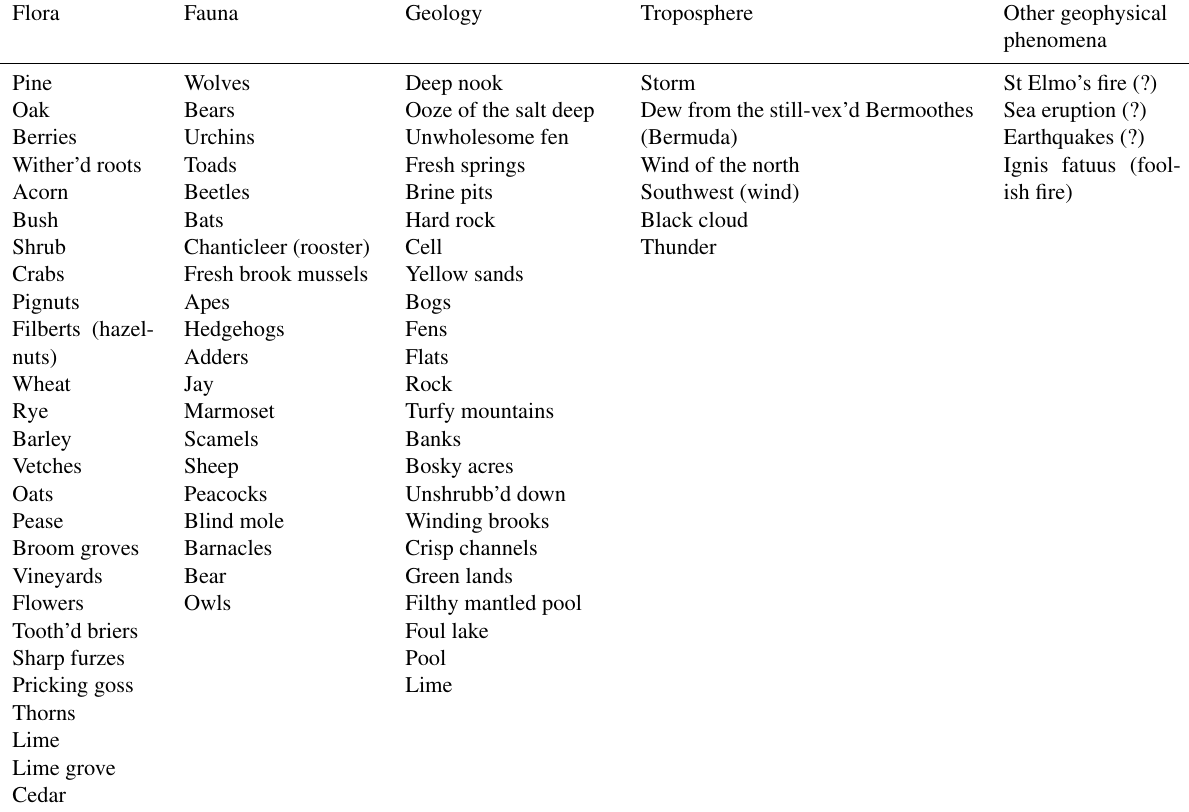
Table 1. The terms related to the flora and fauna, geology and the troposphere as collected by the author from the play. In the last column are some geophysical phenomena, as suggested from the verses analysed in the paper.